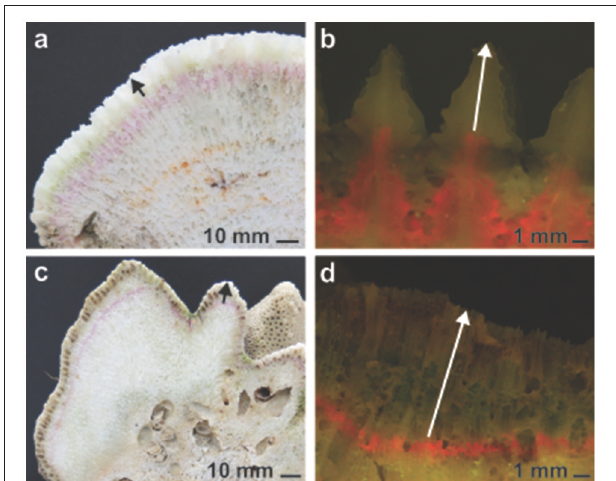
FIGURE 2 | Representative skeletal slices of Platygyra daedalea (a,b) and Cyphastrea microphthalma (c,d) colonies used to measure coral growth in the Persian Gulf and Oman Sea. Annual linear extension was measured across each colony from the edge of the incorporated and alizarin stain (red line, fluorescently excited in b,d ) to the periphery of the skeleton (indicated by arrows). Density was measured in skeletal subsamples from each colony, approximating the annual band of